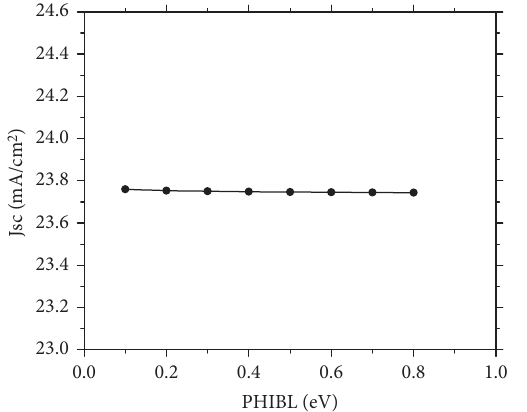
Figure 10: J - V and P - V plots of the proposed solar cell.